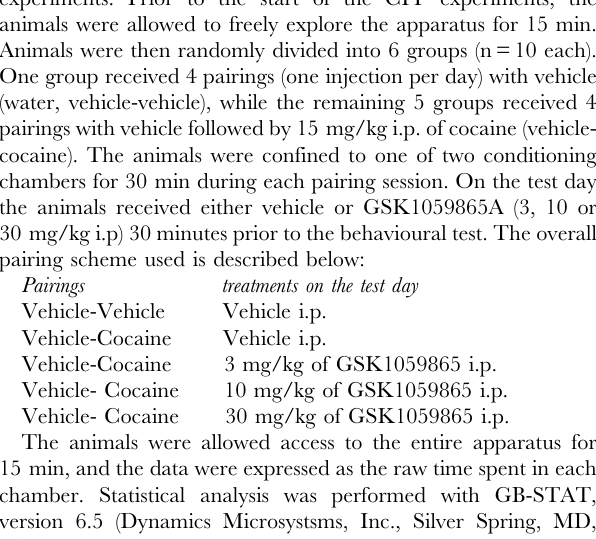
Figure S1 Time–profile of the temporal components identified with WCA [52] in groups 1–2 (Regr 1), and 3–4 (Regr 2). The regressors were used as model function for GLM analysis as detailed in the methods section. Figure S2 Temporal profile of mean arterial blood pressure (MABP) produced by intraperitoneal pretreatment (Left) or amphetamine challenge (Right); Data are plotted as mean 6 SEM within each group. Upper and lower cerebral blood flow autoregulation range under halothane anaesthesia are illustrated by dashed lines at 120 and 60 mmHg, respectively [19]; Ox1R ant :